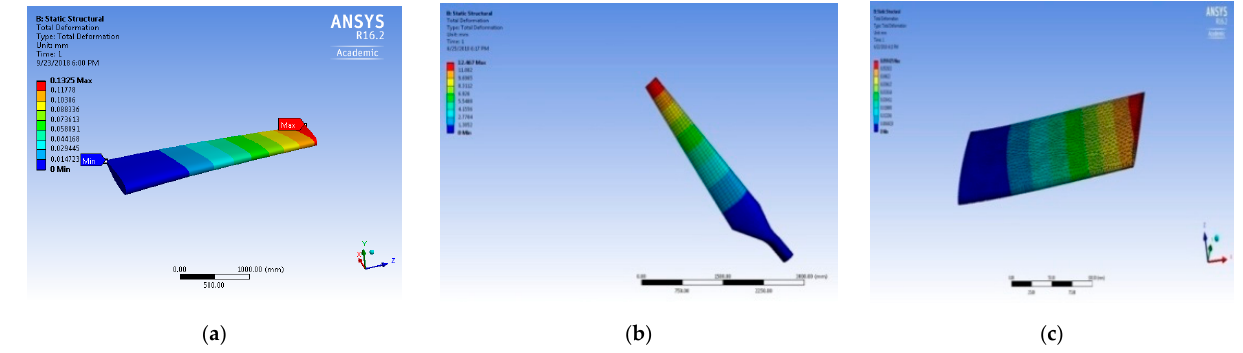
Figure 16. Deformed structures of Al-alloy, Kevlar, and GFRP respectively–structural outcomes. ( a ) Structural displacements of airplane wing. ( b ) Structural displacement of wind turbine blade. ( c ) Structural displacement of UAV wing.